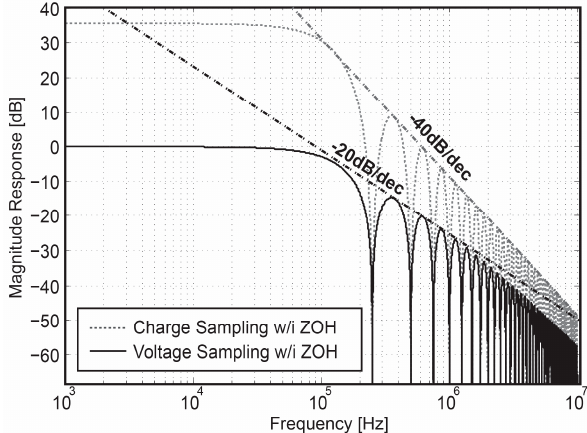
Figure 2. Transfer functions of the charge-domain sampling vs. voltage-domain sampling. The overall roll-off of the transfer function of charge-domain is − 40 dB, one − 20 dB introduced by the zero-order hold (ZOH) effect by the discrete-time sampler, the additional − 20 dB introduced by the charge-domain sampler.